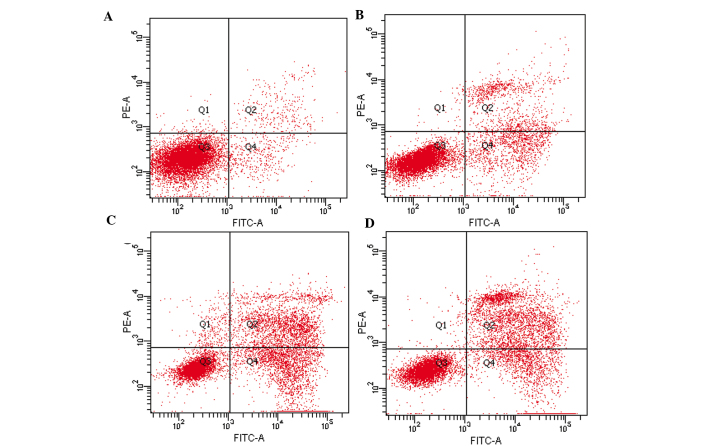
An Annexin V/PI apoptosis kit was used to quantify the percentage of cells undergoing apoptosis (X axis, Annexin V and Y axis, PI). Puerarin and 5-FU treatment alone and in combination induce apoptosis in SMMC7721 cells. SMMC7721 cells in (A) the control group and treated with (B) puerarin (1,600 μM), (C) 5-FU (160 μM) or (D) the two drugs in combination for 48 h. The Annexin V+/PI− cells were apoptotic cells, and the Annexin V−/PI+ were necrotic cells. The percentages indicate the proportion of apoptotic cells. Puerarin alone or in combination with 5-FU was found to significantly induce apoptosis compared with the control group (P<0.01), and the degree of apoptosis induced by the combined treatment was greater than the effect of puerarin or 5-FU alone (P<0.01).